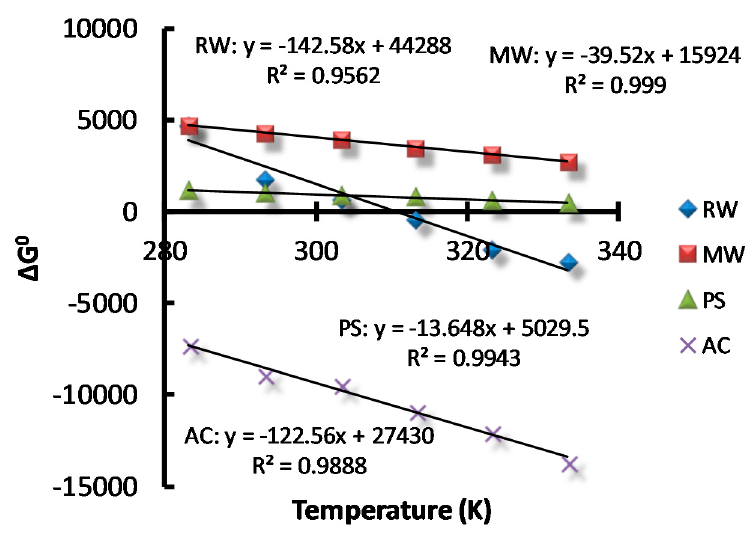
Figure 6. Plot of ∆ G ◦ vs. temperature. Figure 6. Plot of Δ G° vs. temperature. Table 3. Thermodynamic parameters for AB adsorption.